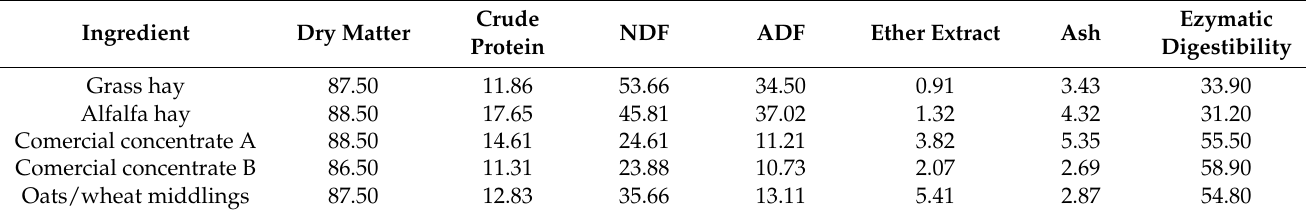
Table 1. Chemical composition and enzymatic digestibility of ingredients used for experimental diets (g/100 g DM).